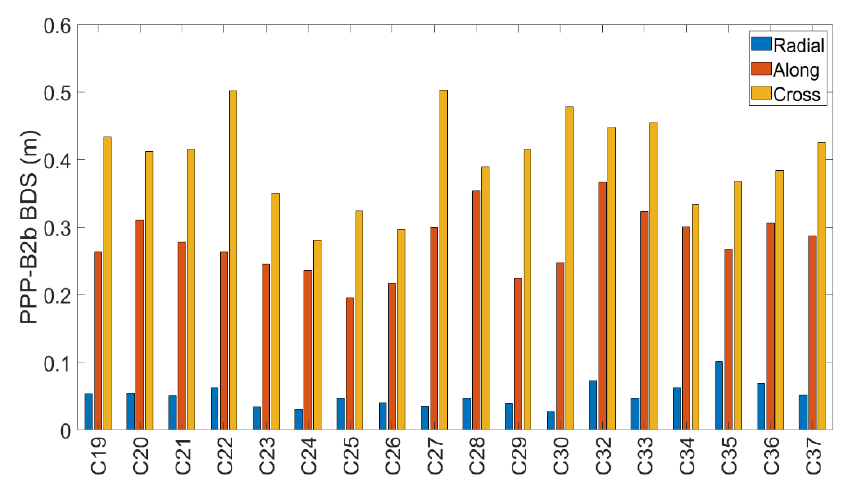
Figure 5. RMS values of BDS-3 orbit errors for the PPP-B2b products.